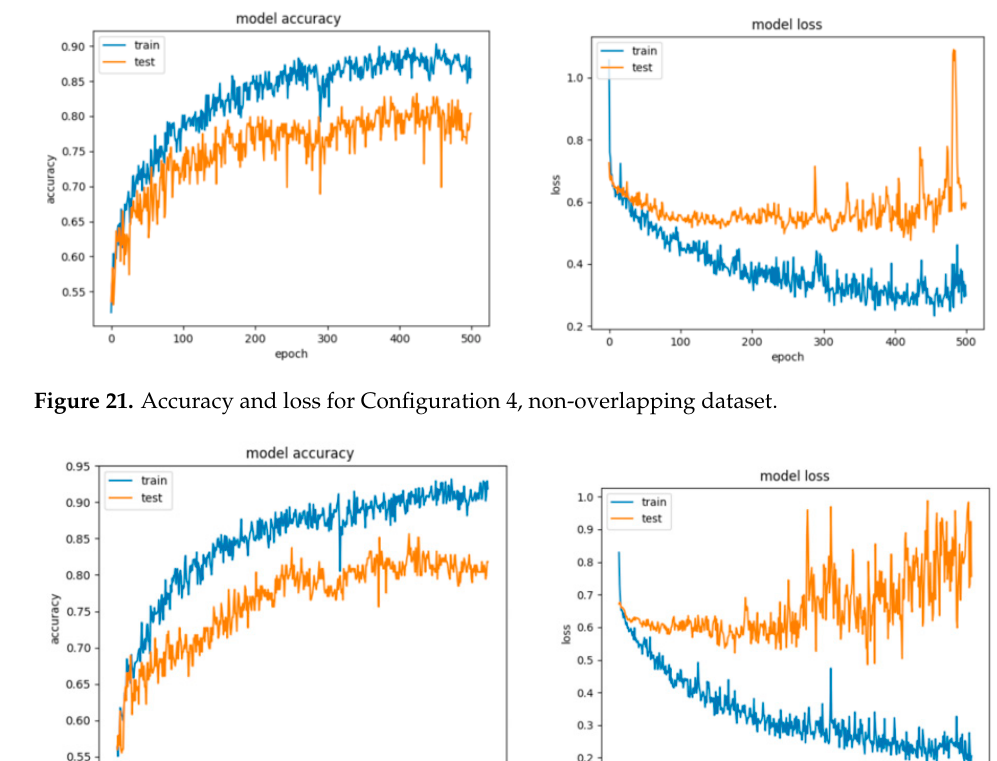
Table 10. Classification scores for Configurations 1–5, for the non-overlapping dataset. Figure 22. Accuracy and loss for Configuration 5, non-overlapping dataset. Figure 22. Accuracy and loss for Configuration 5, non-overlapping dataset.